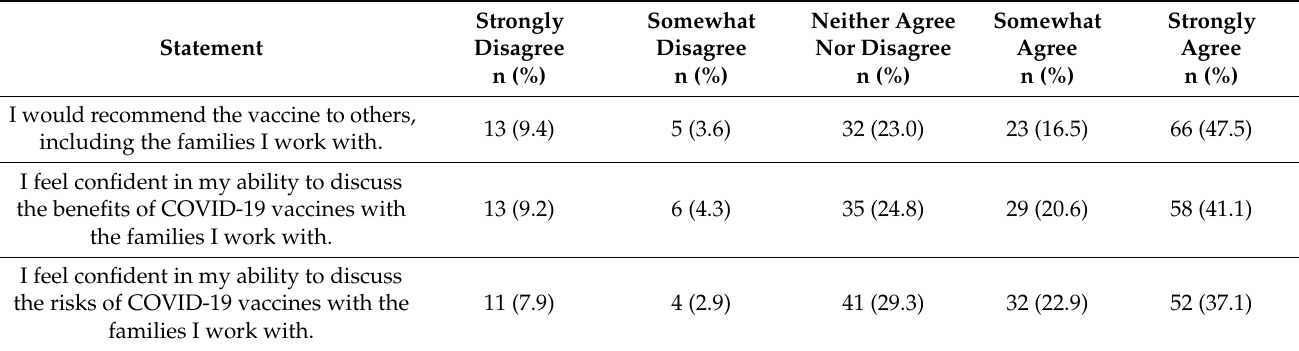
Table 2. Intentions and Confidence for COVID-19 vaccine conversations, Delaware Family Child Care Providers,